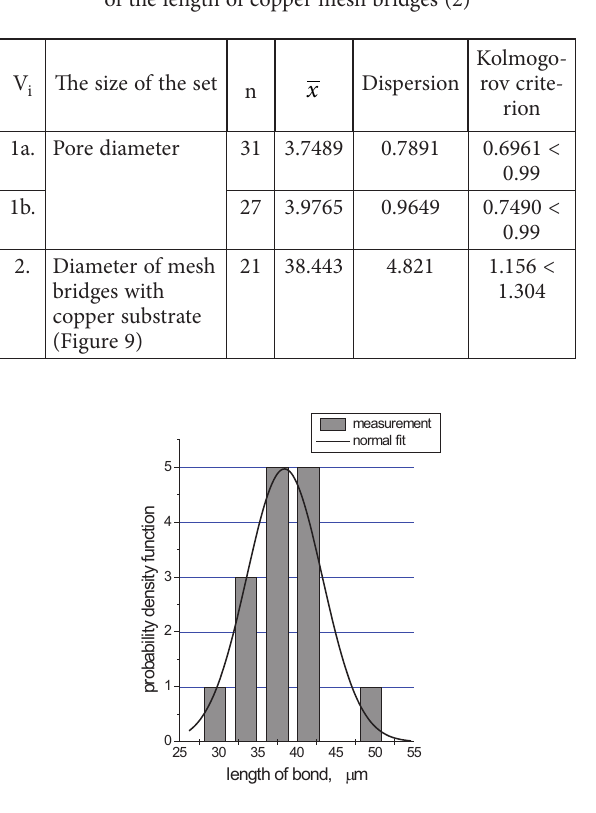
Figure 9. Quantitative distribution function of diffusion bridges between the copper surface and randomly spun fibrils (diameter of mesh bridges with copper substrate)